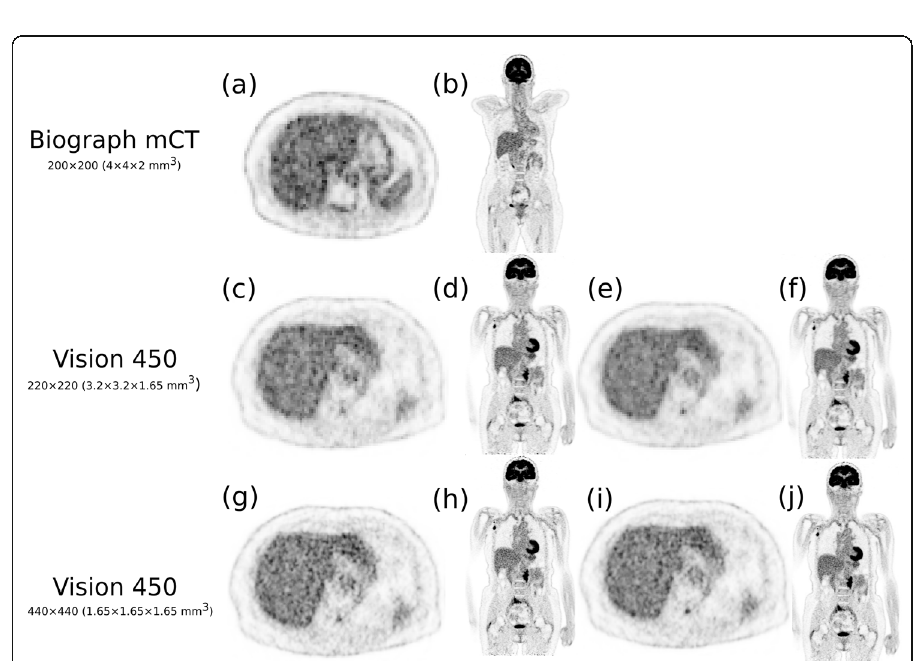
Fig. 7 18 F-FDG-PET evaluated for two patients sharing the same morphological properties and injected activity (173 MBq): breast cancer imaged on the Biograph mCT ( a , b ) and follicular lymphoma imaged on the Biograph Vision 450 ( c , d , e , f , g , h , i , j ). Reconstruction parameters for mCT was OP-OSEM+PSF + TOF, 3 iterations, 21 subsets, and no post-filtering (200 × 200 matrix size) and OP-OSEM+PSF + TOF, 4 iterations, 5 subsets, and no post-filtering for the Biograph Vision 450. The reduction factor as compared with time acquisition used for mCT was 1.89 for the 220 × 220 matrix size ( c , d ) and 1.34 for the 440 × 440 matrix size ( g , h ). Data reconstructed using a time per step identical to those of Biograph mCT are presented in ( e , f ) for the 220 × 220 matrix size and ( i , j ) for the 440 × 440 matrix size. The IR computed on the right liver lobe was almost identical: 0.176 ( a , b ); 0.178 ( c , d ); and 0.183 ( g , h ). The IR for ( e , f ) was 0.118 and 0.142 for ( i , j ). Grey scale is identical for all